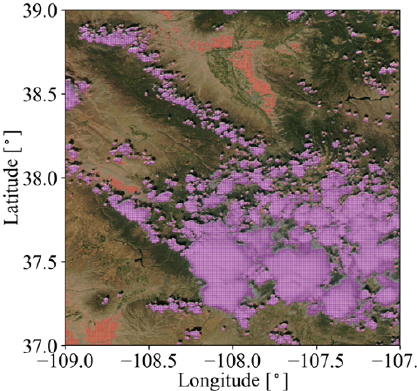
Figure C1. Cloud mask for the scene shown in Fig. 2. Red and purple indicate the pixels identified as cloudy through the primary thresholding (Eq. C1), and purple indicates the pixels identified as cloudy after applying the secondary filter (Eq.